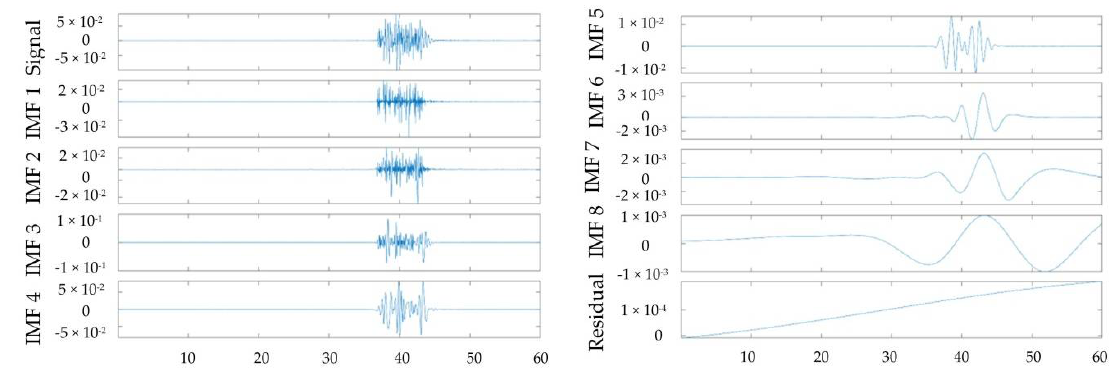
Figure 16. IMFs of a typical response of Segment 2.